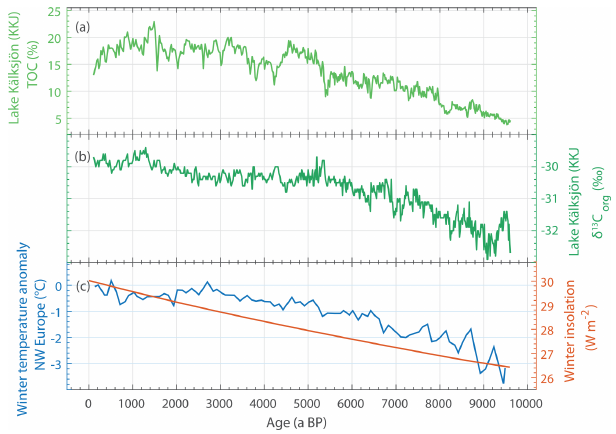
Figure 10. Multi-millennial trends in paleoclimate and orbital forc- ing during the last ∼ 9600 years. (a) Total organic carbon (TOC) contents from Lake Kälksjön (KKJ) sediments. (b) δ 13 C org from KKJ sediments. (c) Winter (January) insolation at 60 ◦ N (Laskar et al., 2004) and winter temperature anomaly in northwestern Europe (Davis et al.,